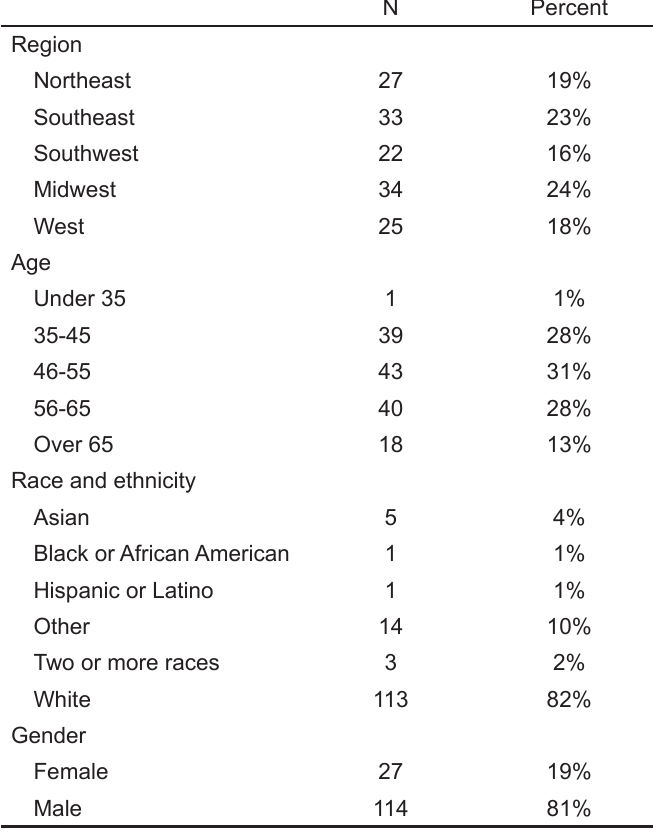
Table 1. Demographic characteristics of